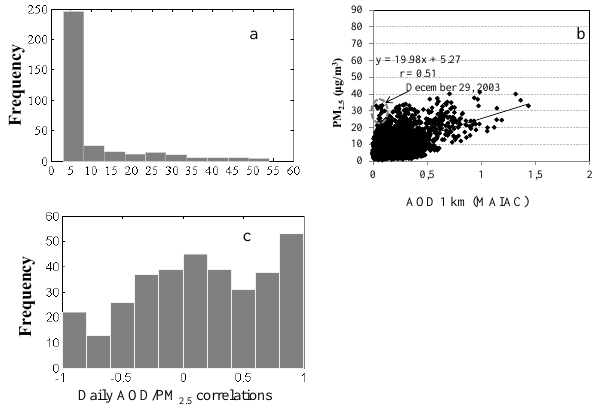
Fig. 9. MAIAC data quality on days when MYD04 was not avail- able. (a) Number of collocated AOD–PM 2 . 5 pairs with at least 3 ob- servations retrieved by MAIAC ( N = 344 days). (b) MAIAC AOD– PM 2 . 5 relationship on days when MYD04 has no collocated obser- vations; (c) frequency distribution of daily AOD vs. PM 2 . 5 correla-